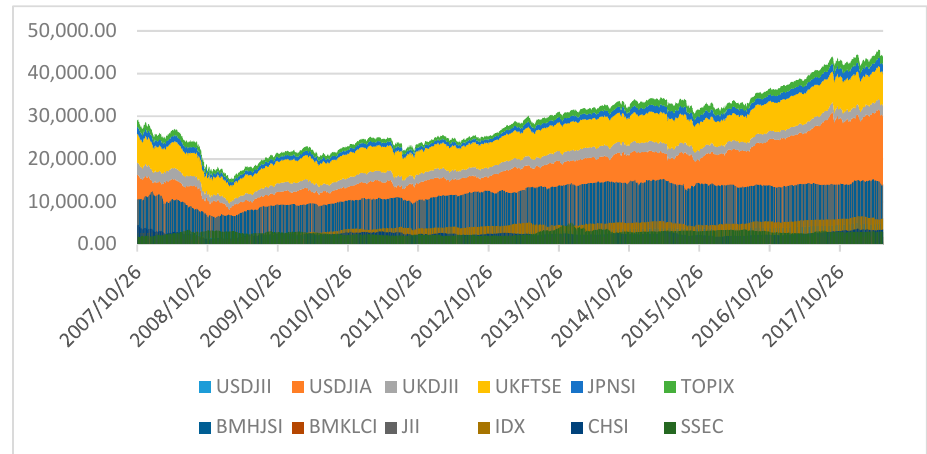
Figure 2. Stock prices performance.